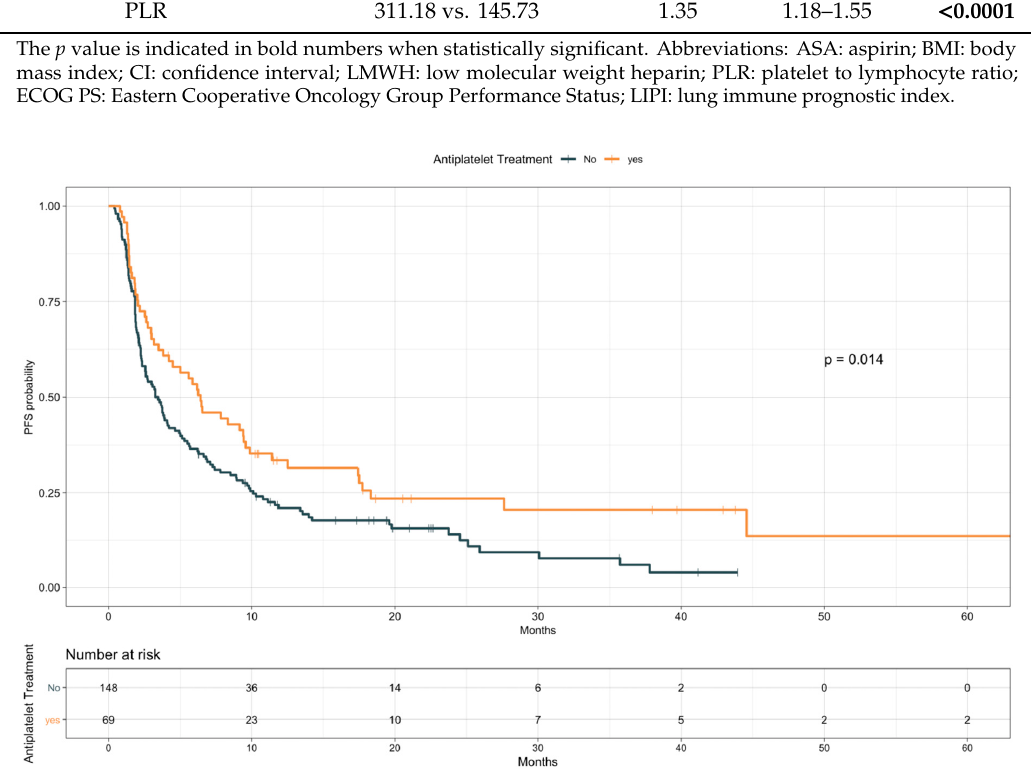
Figure 4. Progression-free survival according to antiplatelet treatment.